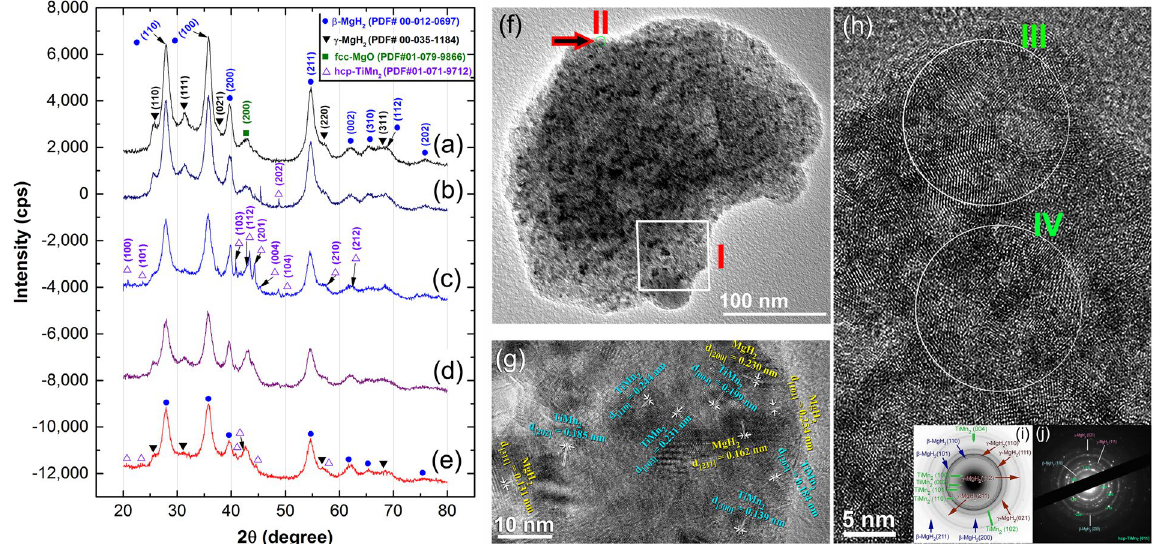
Figure 1. Structural characteristics of nanocrystalline MgH 2 and nanocomposite MgH 2 /5 wt.% TiMn 2 powders milled for different RBM time. ( a ) XRD patterns of hcp-Mg powder obtained after ball milling under 50 bar of H 2 gas atmosphere for 200 h. XRD patterns of as-synthesized MgH 2 powder doped with 5 wt.% TiMn 2 powder and then ball milled for ( b ) 3 h, ( c ) 12.5 h, ( d ) 37.5 h, and ( e ) 50 h. The BFI image of the end-product (50 h) is shown in ( f ), where the HRTEM image for zone I indexed in ( f ) is presented in ( g ). HRTEM image of zone II indexed in ( f ) is presented in ( h ). The NBDPs for zones III and IV shown in ( h ) are elucidated in ( i , j ),